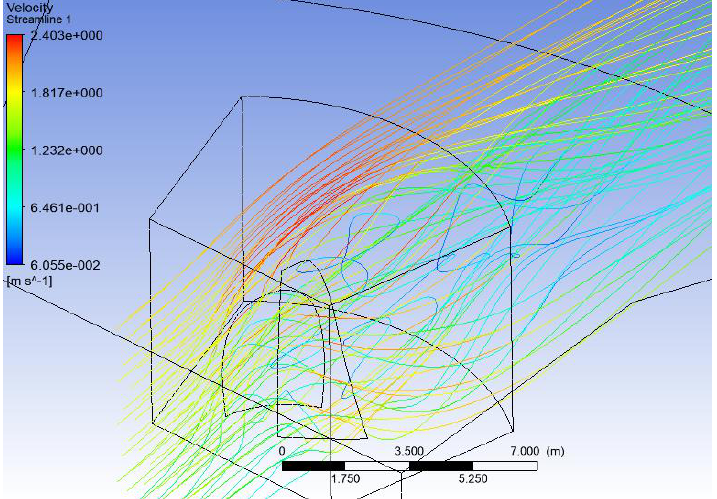
Figure 5. Velocity streamlines for AWA = 90°.